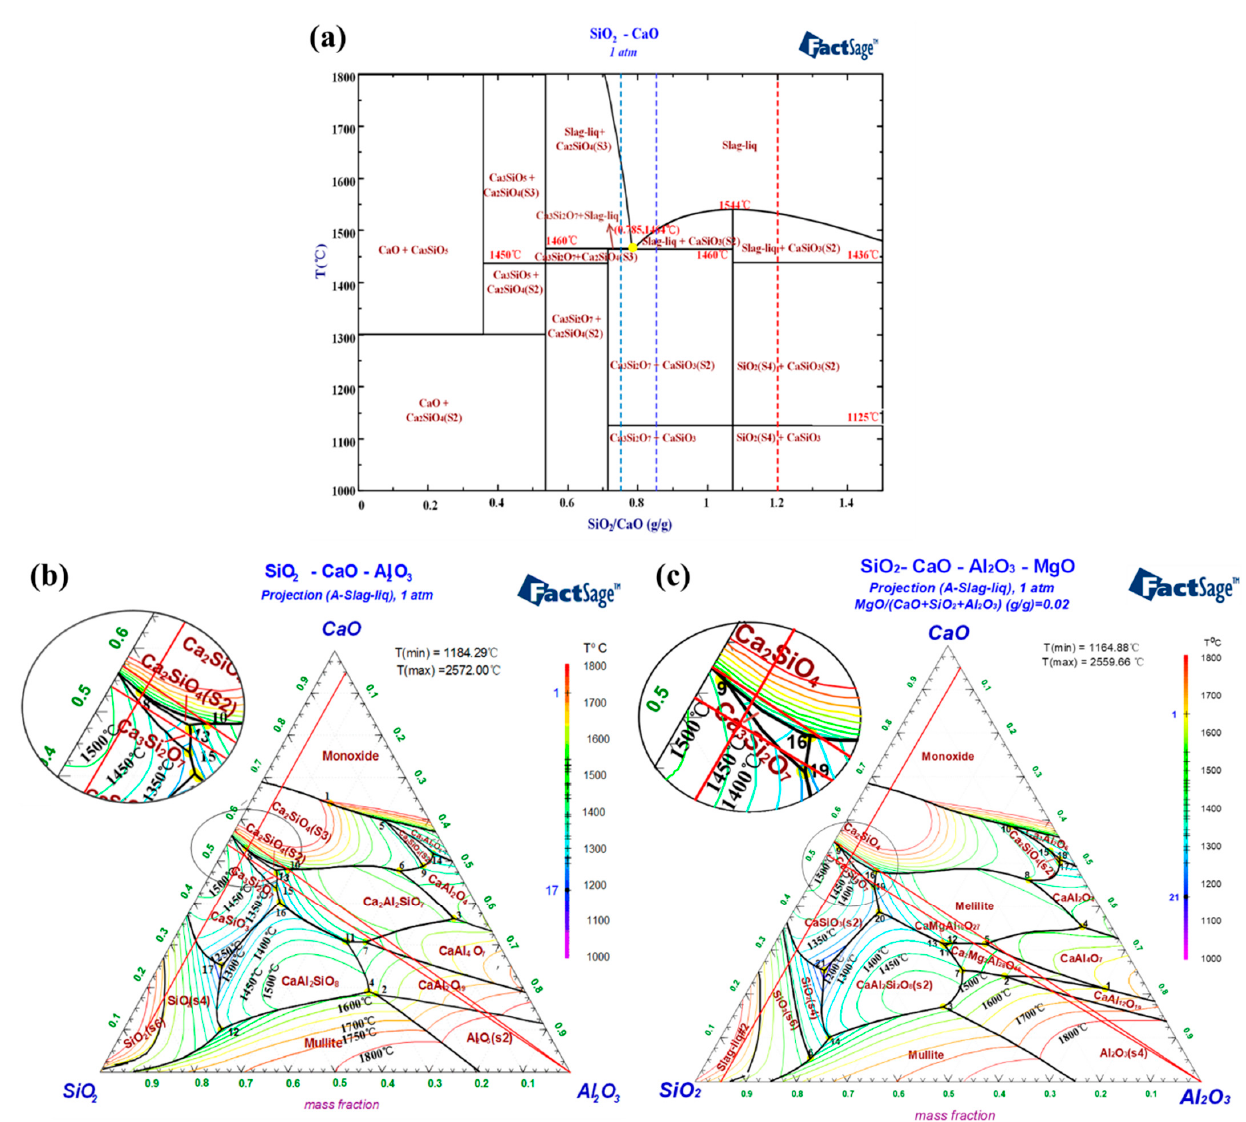
Figure 4. Phase diagrams of SiO 2 -CaO system and SiO 2 -CaO-Al 2 O 3 -MgO system at atmospheric pressure. ( a ) SiO 2 -CaO system; ( b ) SiO 2 -CaO-Al 2 O 3 system; ( c ) SiO 2 -CaO-Al 2 O 3 -MgO system.